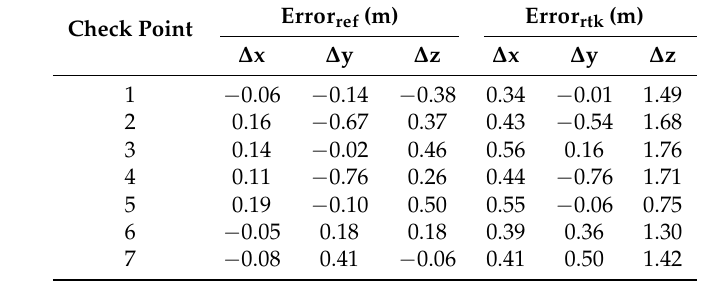
Table 10. Errors of the coordinates of check points compared to RTK GNSS measurements and the coordinates triangulated using aerial images: Germering dataset.